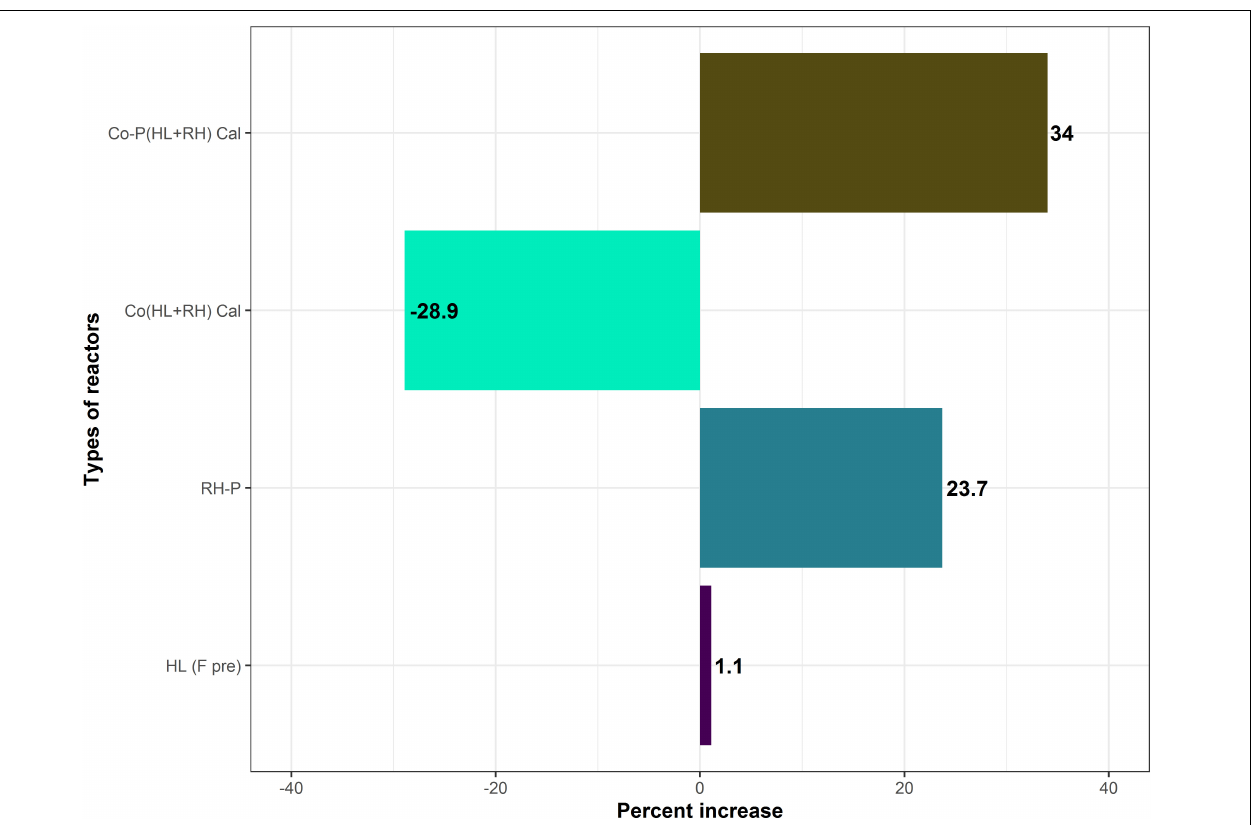
FIGURE 4 | Percent increase in yield of HL (hydrolysate in comparison with feathers), RH-P (rice husk-pretreated in comparison with non-pretreated), and Co (HL+RH) co-digestion (hydrolysate + rice husk in comparison with calculated co-digestion of hydrolysate + rice husk) is decreased, Co-P (hydrolysate + rice husk in comparison with calculated co-digestion of hydrolysate + rice